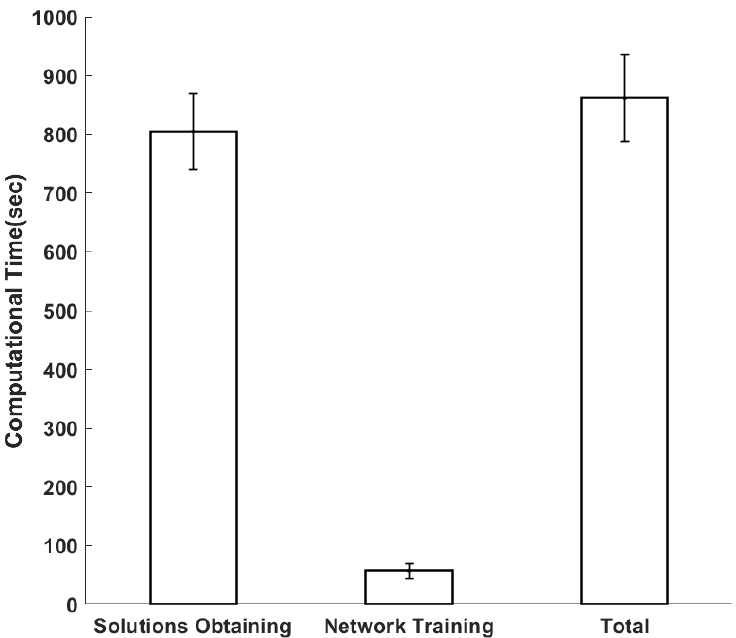
Figure 12. Average Processing Time for Different Stages in the LSTM